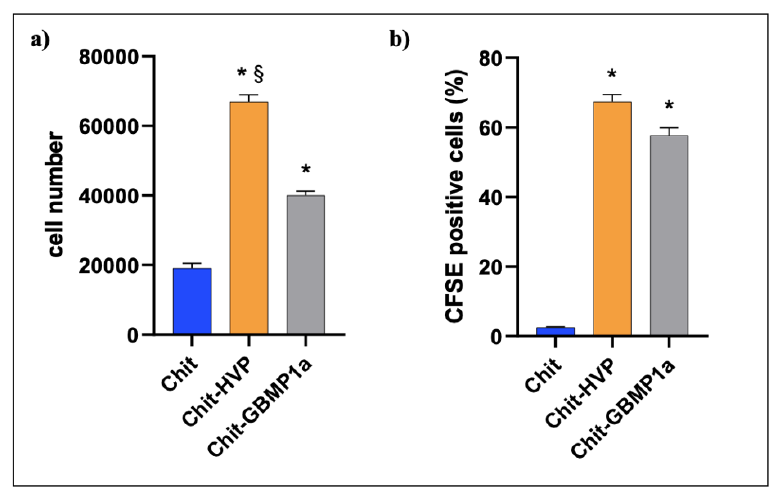
Figure 5. Cell viability assays. ( a ) Osteoblast adhesion at 2 h and ( b ) osteoblast proliferation at 4 days of culture on Chit, Chit-HVP, and Chit-GBMP1a matrices. * p -value < 0.05 vs. Chit; § p -value < 0.05 vs. Chit-GBMP1a.